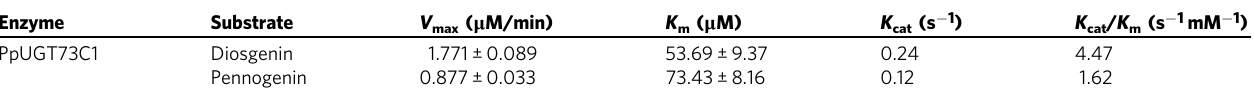
Table 1 The enzymatic kinetics of PpUGT73C1 catalyzed diosgenin and pennogenin.